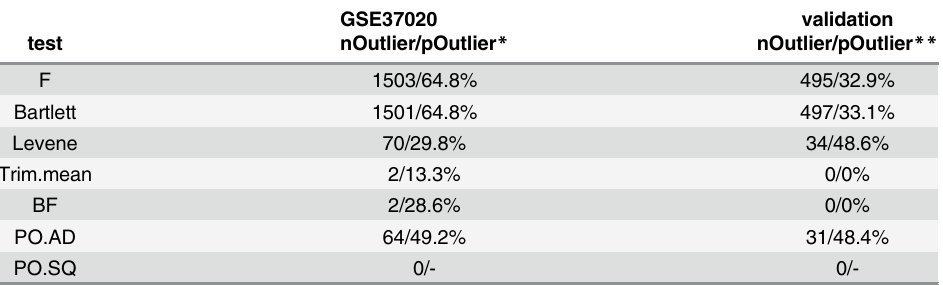
Table 3. Number/proportion of significant CpG sites that contain outliers detected in GSE37020, and the number/proportion of these CpG sites that also contains outliers detected via GSE20080.